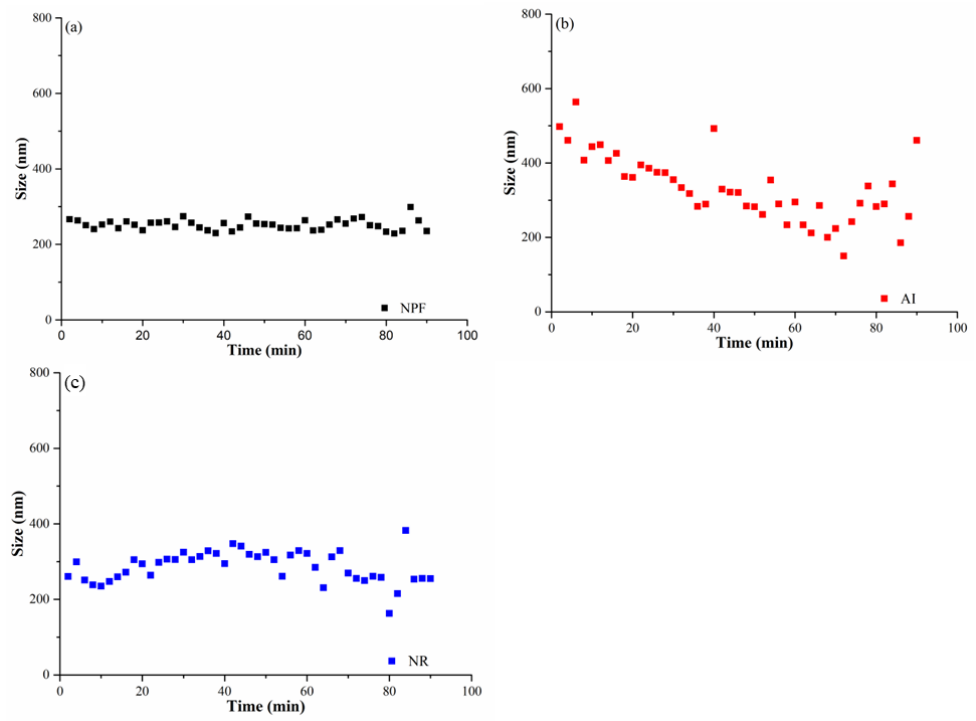
Figure 1. The aggregation of NPF, AI and NR in ultrapure water as a function of time: ( a ) NPF: ( b ) AI: ( c ) NR.